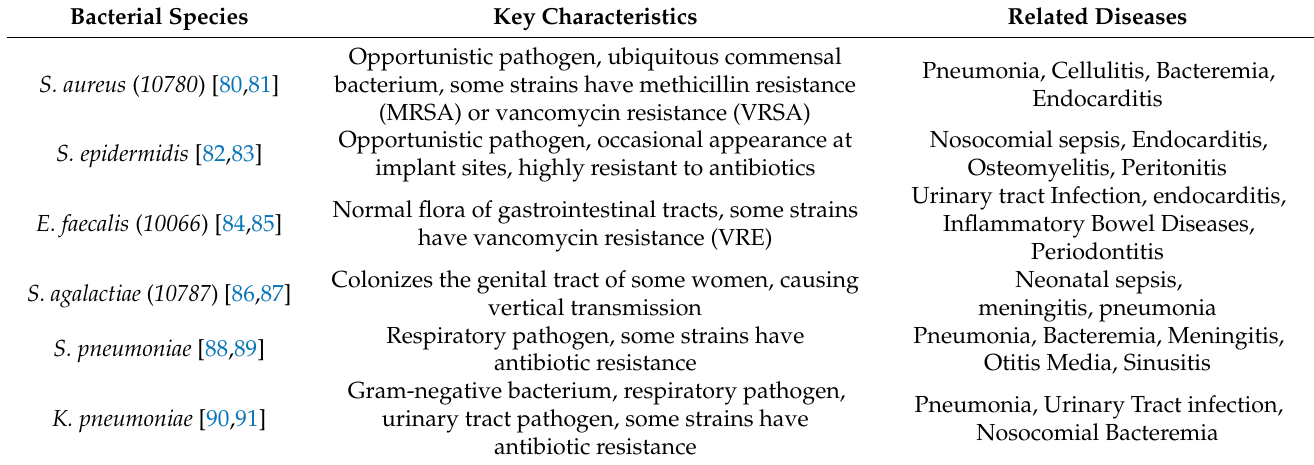
Table 3. Key Characteristics and Related Diseases of BSL-2 Bacteria Tested in the Present Study. Key Characteristics